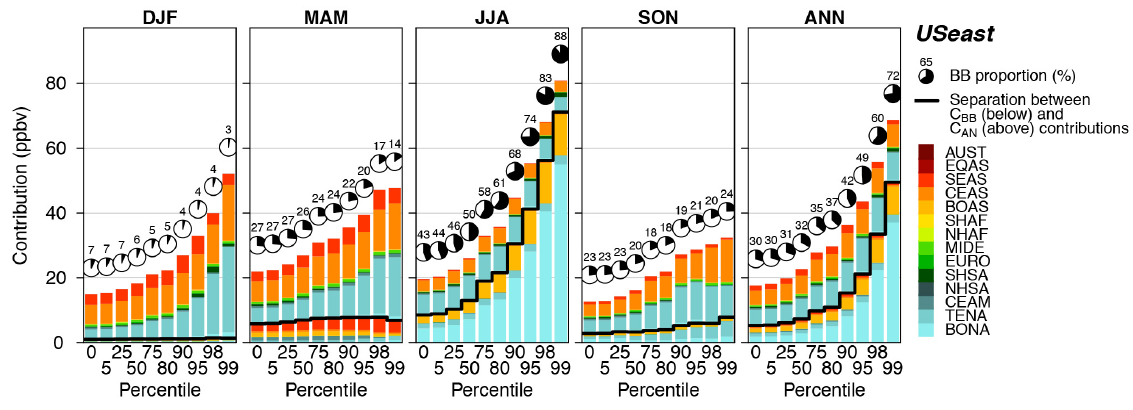
Figure 17. Same as Fig. 16 for the USeast